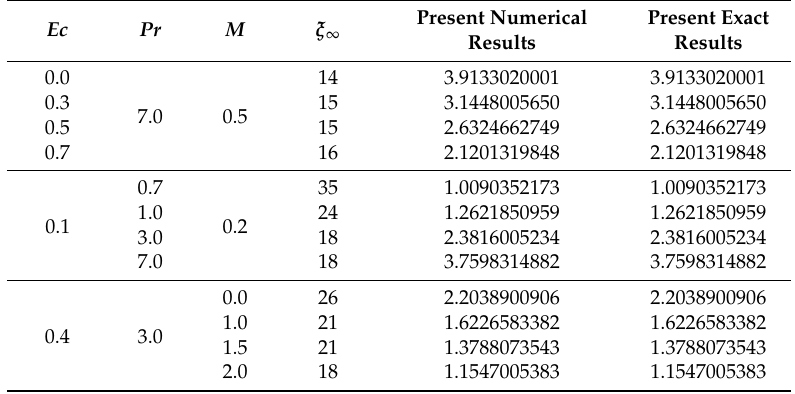
Table 3. Validation of our numerical results obtained by CGLSM for Re − 0.5 s Nu s with those of the closed form exact solution, in the case where ε = φ = 0 and κ = ∞ , when N = 100.